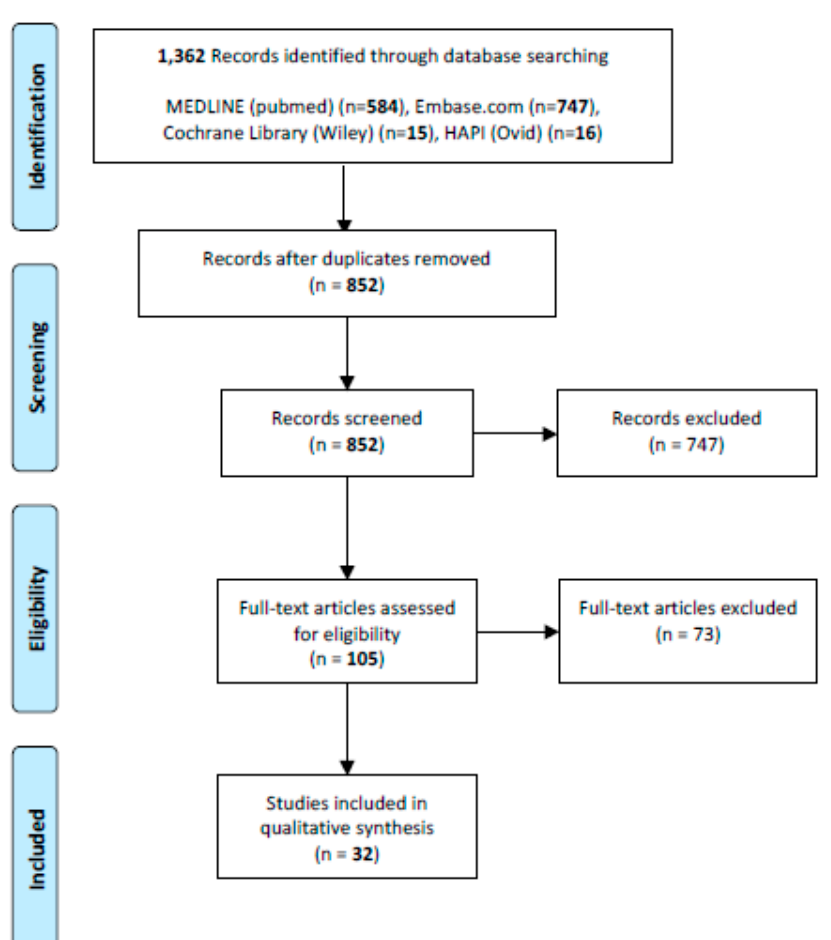
Figure 1. PRISMA (Preferred Reporting Items for Systematic Reviews and Meta-Analyses) chart.